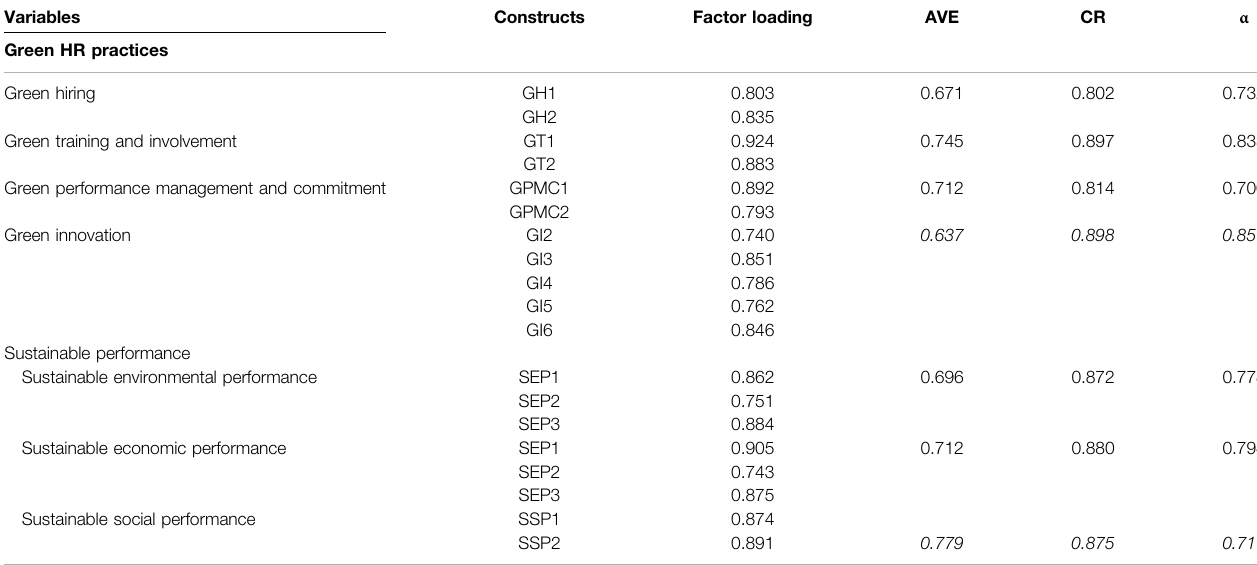
TABLE 2 | Inner model